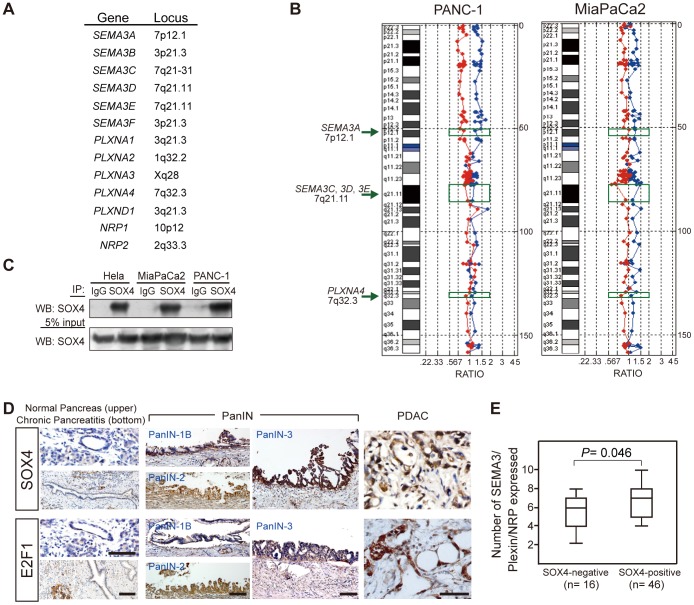
SOX4 expression in PDAC correlates with the total number of expression of SEMA3/Plexin/NRP1.(A) gene loci of each human SEMA3, Plexin, and NRP gene. (B) representative array CGH on chromosome 7 with genomic DNA extracted from PANC-1 and MiaPaCa2 cells, respectively, compared with normal human genomic DNA (blue dots and line: forward experiment, cell line versus control; red dots and line: reverse experiment, control versus cell line). No significant gene amplification (> =  or < =  2-fold change) was observed around SEMA3A, 3C, 3D, 3E and PLXNA4 gene loci (indicated by green-colored rectangle and arrow). (C) SOX4 is expressed in PDAC cell lines. Cell lysates were immunoprecipitated using anti-SOX4 antibody and immunoblotted with SOX4 or a control IgG antibody. (D) immunohistochemistry of SOX4 and E2F1 in human PDAC cases. SOX4 and E2F1 were both detected in PanIN of different grades and invasive adenocarcinoma, but not in normal ductal and acinar epithelia or in chronic pancreatitis. Scale bar = 100 µm. (E) Rank sum of staining intensity for SEMA3/Plexin/NRP1 correlates with SOX4 expression in PDAC cases. The staining of each section was scored 1–3 to rank its intensity as weak, medium, or strong. Scores of all SEMA3/Plexin/NRP1 immunostaining for each case were summed and correlated with SOX4 expression (NPar Kruskal-Wallis one-way analysis). The median (line within the box), maximal and minimal values (upper and lower lines outside the box, respectively) for each group are shown in the boxplot.